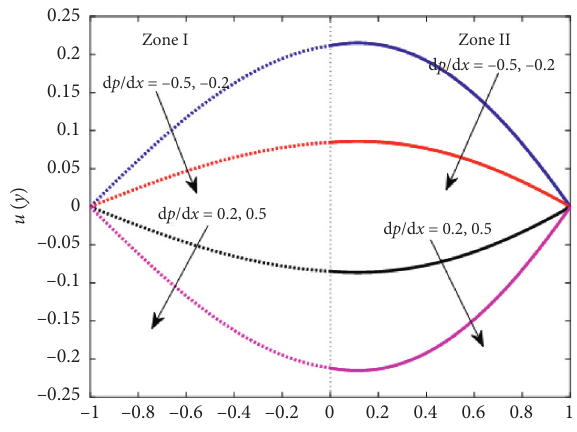
Figure 6: Velocity profiles for various Re.